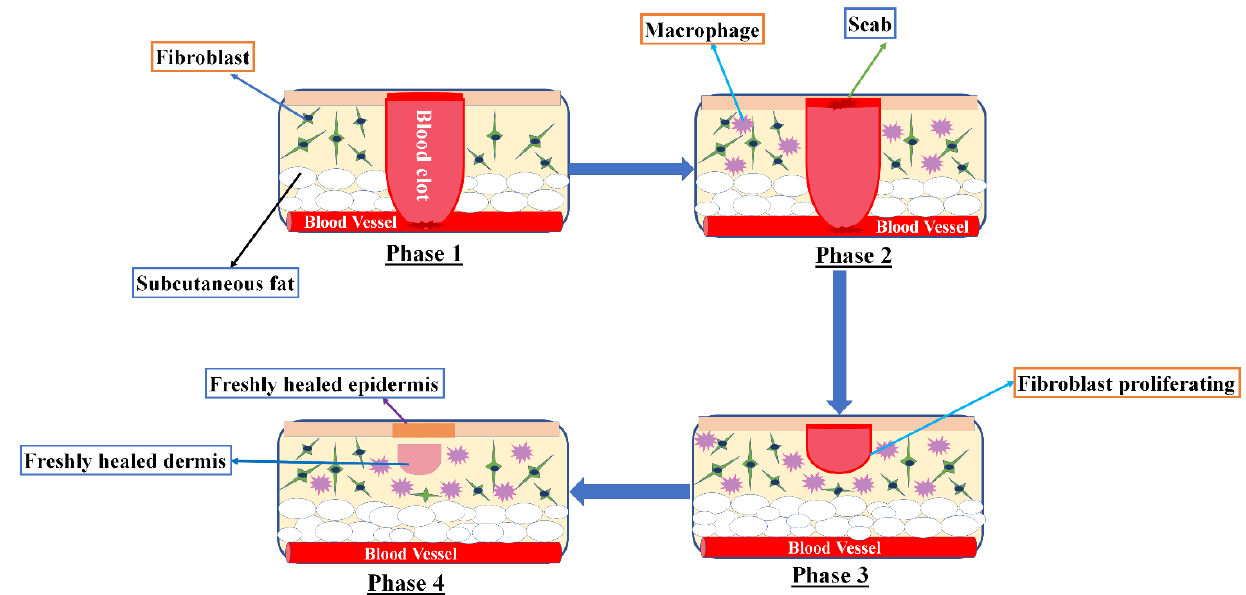
Figure 1. Different phases of the wound-healing process.